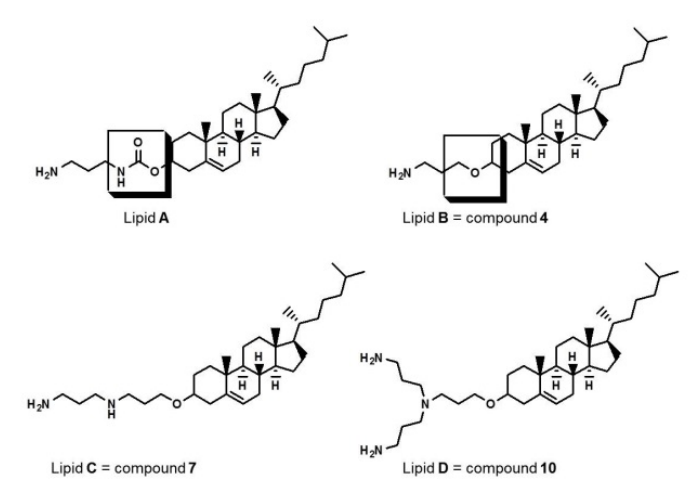
Figure 1. Structures of cholesterol-based cationic lipids. Lipid A has a carbamoyl-linked structure and lipids B – D have ether-linked